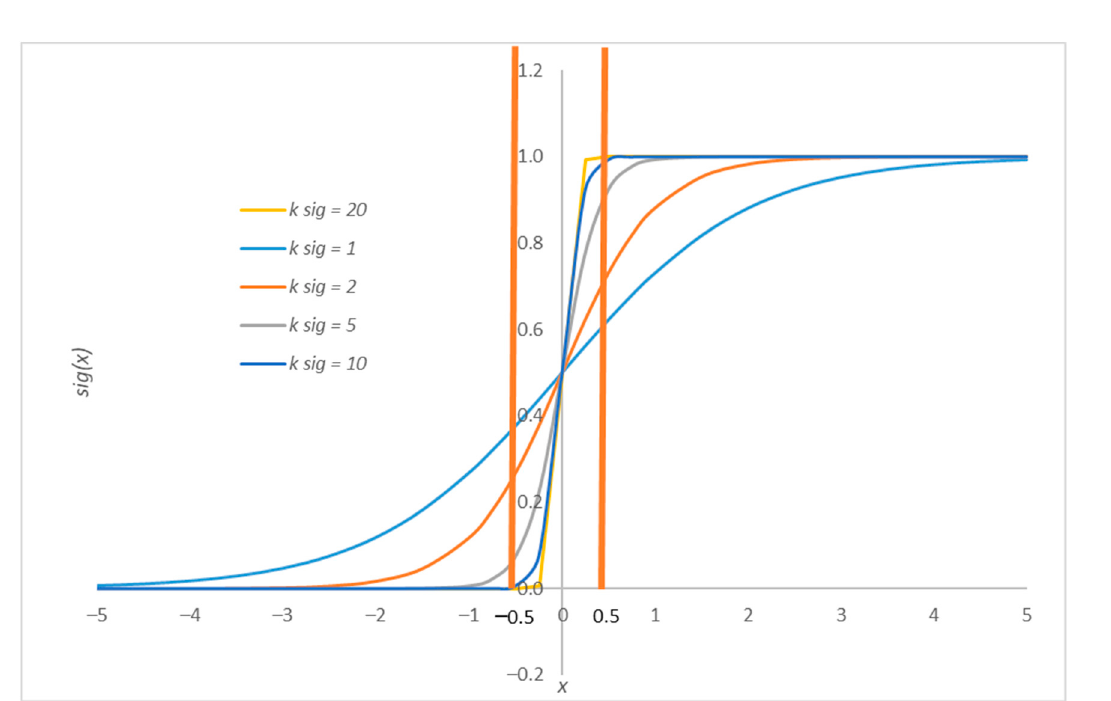
Figure 5. Graph representing a sigmoid function.